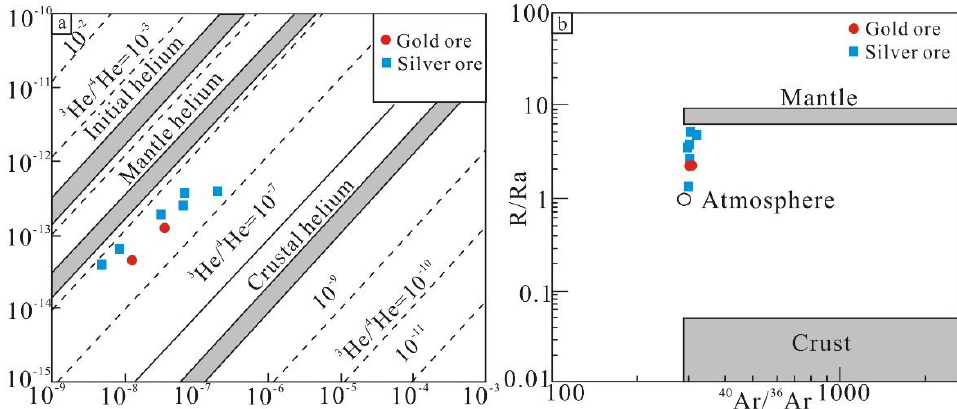
Figure 13. He isotopic data ( a ) and the 40 Ar/ 36 Ar-R/Ra diagram ( b ) of the Changkeng–Fuwan Au-Ag deposit (after